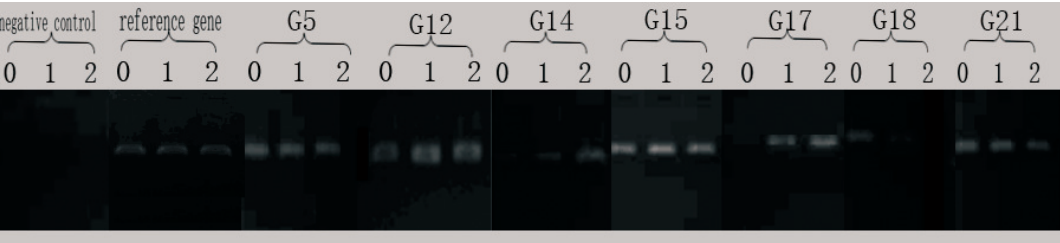
Figure 6. PCR electrophoresis of differentially expressed genes. Notes: 0: ck (LB); 1: test sample 1 ( n -C16); 2: test sample 2 (crude oil).